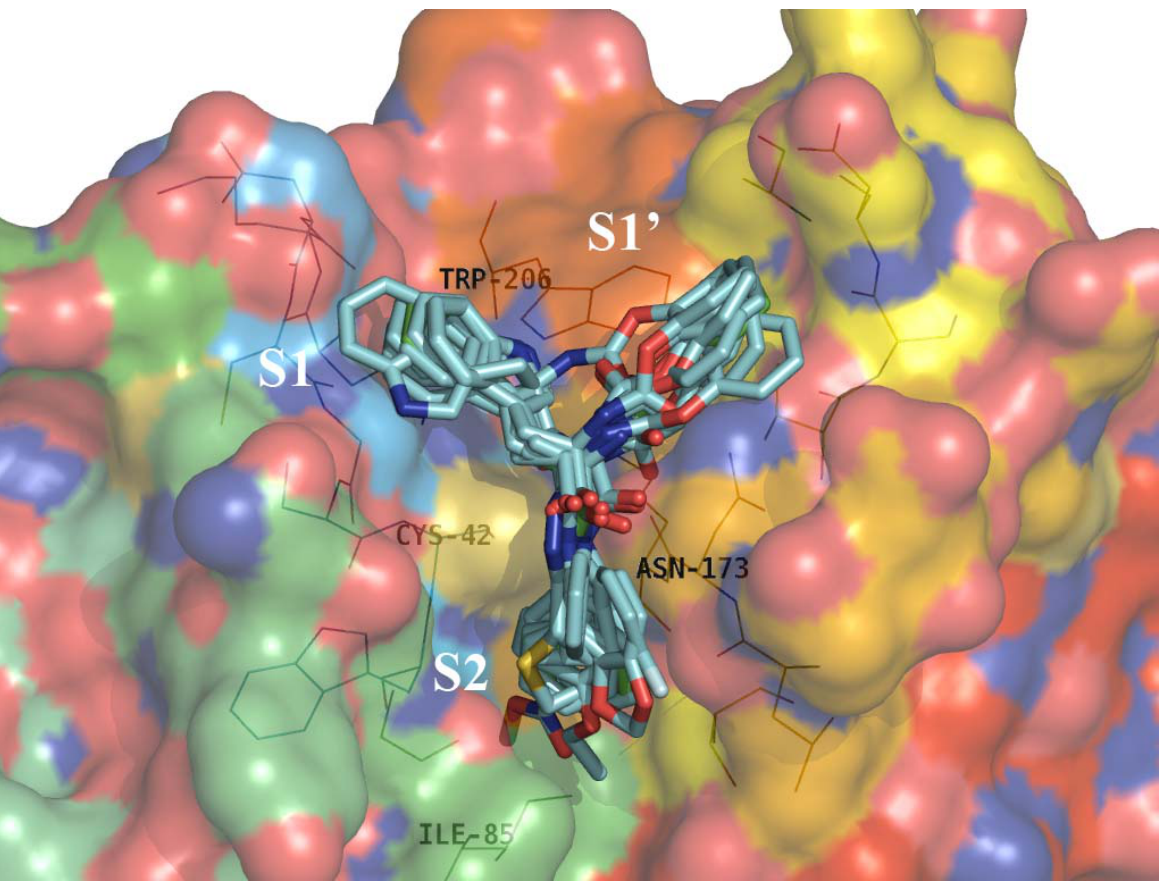
Figure 3. Superimposition of the matched conformations of compounds ( 2a - 2l , cyan) on compound 1 (green) in the active site of FP-2. Hydrogen atoms have been omitted for clarity. Key residues of the binding pocket are shown as lines. The FP-2 surface was colored by electrostatic potential. The sub-sites are labeled as S1, S1’, and S2.